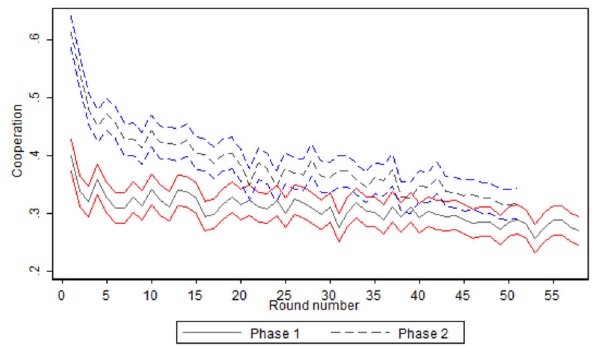
Figure 2. Mean cooperation, by round. [ Notes : cooperation is defined as the mean value of a dummy variable that takes value “1” if the individual cooperates in the round of reference, and takes value “0· for defection. “Experiment” was played in the first phase of the experiment; “Control” was played in the second phase of the experiment. Round number goes from 1 to